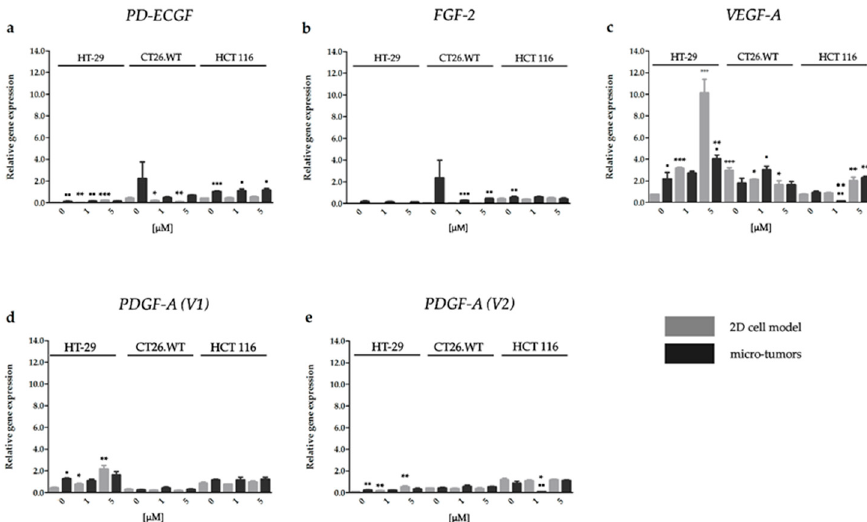
Figure 7. Effect of HP on pro-angiogenic factor gene expression of PD-ECGF ( a ), FGF-2 ( b ), VEGF-A ( c ), PDGF-A (V1) ( d ) and PDGF-A (V2) ( e ). The mRNA was quantified by RT-qPCR and normalized to the expression of phosphomannomutase 1 ( PMM1 ). All results are expressed as the mean value of at least two independent experiments ±SD. The groups treated with HP were compared with untreated control (* p < 0.05, ** p < 0.01, *** p < 0.001). The experimental micro-tumors and cells cultivated in 2D cell models were compared with each other ( ▪ p < 0.05, ▪▪ p < 0.01, ▪▪▪ p < 0.001). The non-treated groups of experimental micro-tumors similarly to non-treated groups of cells cultivated in 2D cell models were compared with each other in VEGF-A group ( ₀₀₀ p < 0.001). Data were analyzed with one-way ANOVA with Tukey´s post-test or t -test.